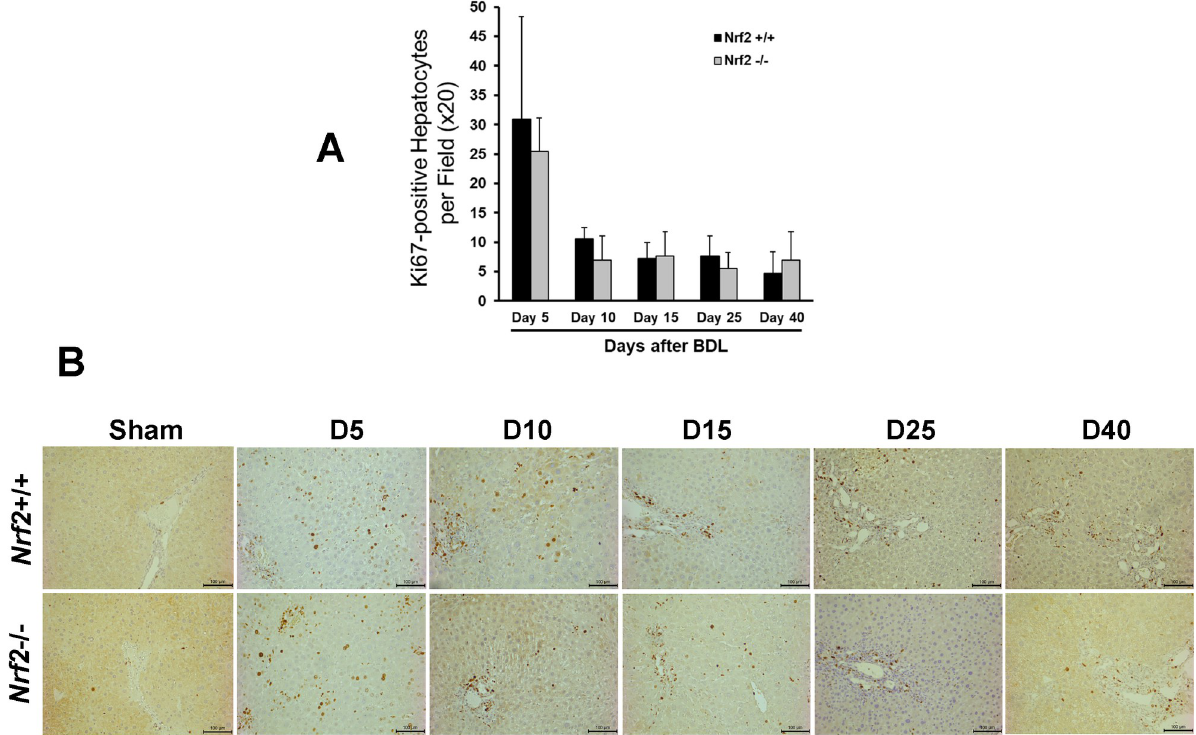
Fig 4. Hepatocyte proliferation induced by bile duct ligation (BDL) in Nrf2 +/+ and Nrf2 -/- mice. Ki-67 immunostaining was performed using the formalin-fixed and paraffin-embedded liver sections prepared from the livers of mice after BDL or sham operation. (A) Ki67+ hepatocytes were counted at 200x magnification in 5 randomly chosen fields per section. The results are shown as means per field ± SD (n = 5). (B) Representative liver sections showing Ki67+ cells with the nuclei stained dark brown.